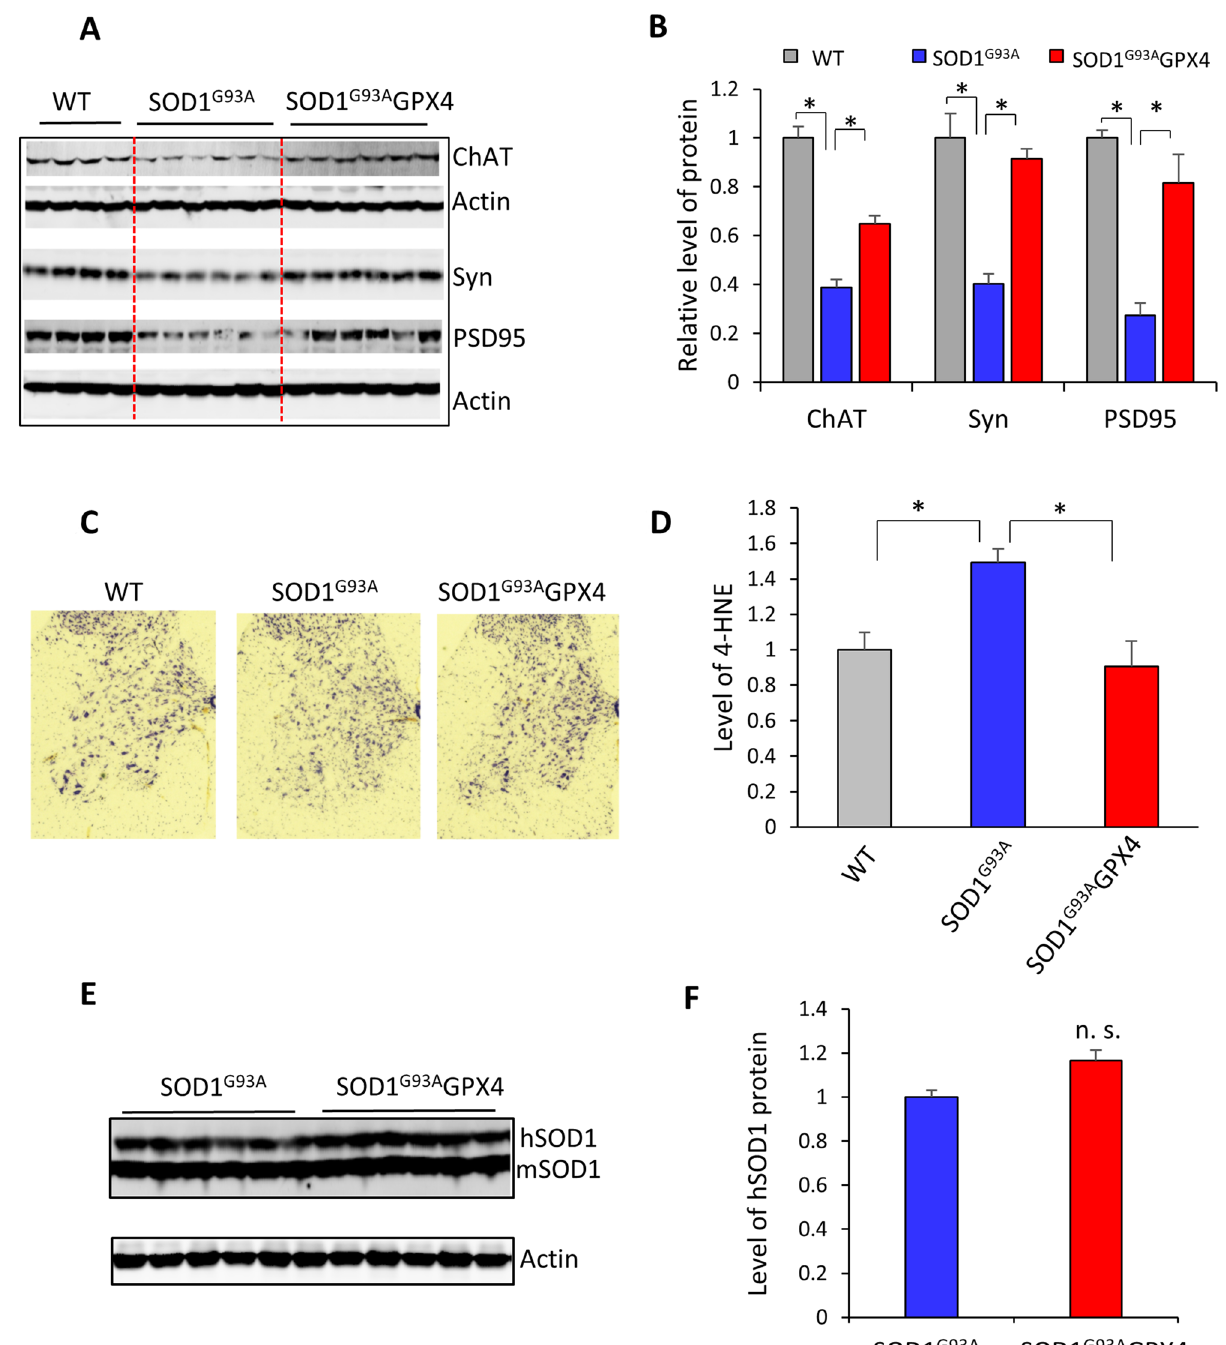
Figure 4. Ameliorated motor neuron degeneration in SOD1 G93A GPX4 mice. ( A ) Graph of western blot results comparing levels of neuronal marker proteins in lumbar spinal cord tissues of WT, SOD1 G93A , and SOD1 G93A GPX4 mice. Syn: synaptophysin. Ages of mice: 120 days. ( B ) Quantified results of western blots. n = 4 for WT and 6 for both SOD1 G93A and SOD1 G93A GPX4. *: p < 0.05. ( C ) Images of Nissl-stained lumbar spinal cord sections. ( D) Levels of 4-HNE protein adducts in lumbar spinal cord tissues of WT, SOD1 G93A and SOD1 G93A GPX4 mice. n = 3 for WT and 4 for both SOD1 G93A and SOD1 G93A GPX4. *: p < 0.05. ( E ) Graph of western blots showing levels of hSOD1 and mSOD1 proteins in the lumbar spinal cord tissues of SOD1 G93A and SOD1 G93A GPX4 mice at 120 days of age. ( F ) Quantified result of hSOD1 protein levels. n.s.: not statistically